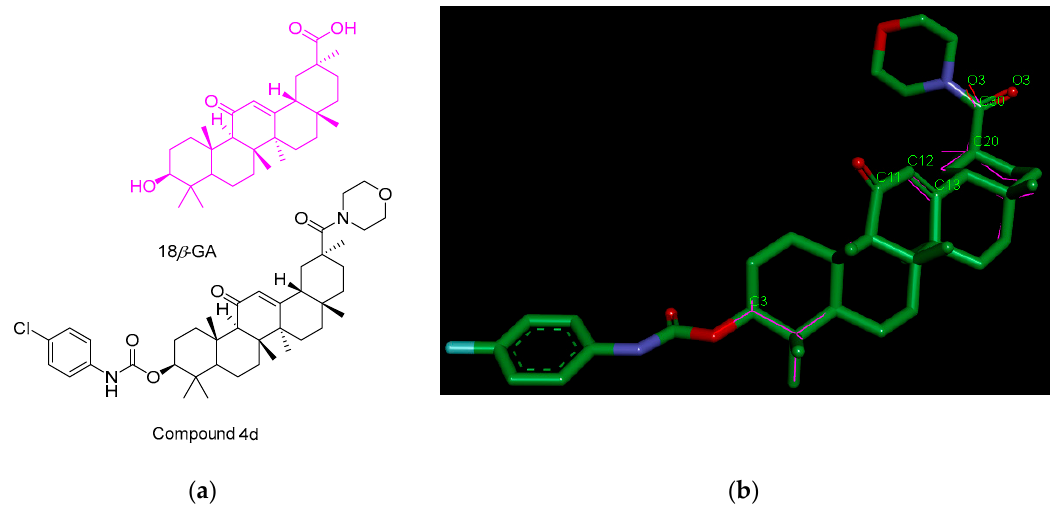
Figure 6. ( a ) Molecular structures and ( b ) overlay crystal structures of 18 β -GA (Lines) compound 4d (Sticks).